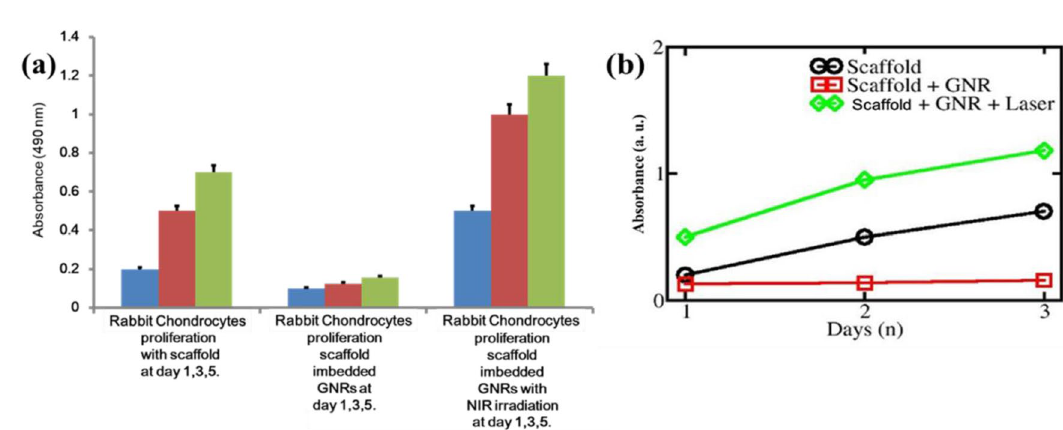
Figure 4. Optical image of rabbit chondrocyte ( a ) with scaffold, ( b ) immersed in SGNR, and ( c ) immersed in SGNR and treated with NIR irradiation.